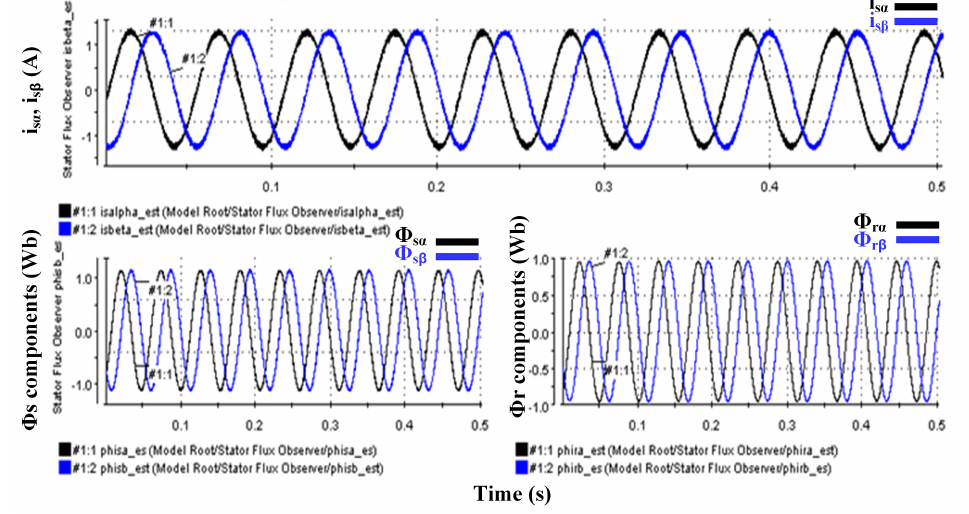
Figure 25. Experimental results of the stator current, stator flux, and rotor flux components of the improved